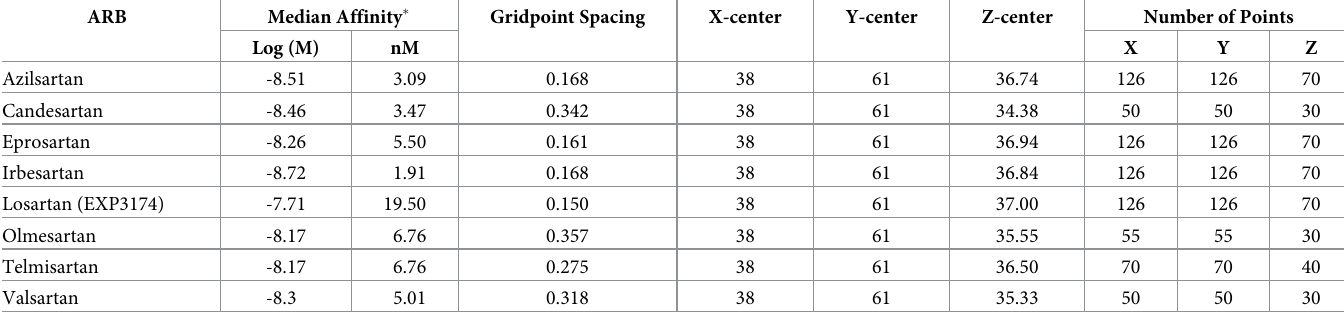
Table 3. Optimal AutoDock 4.2 parameters identified to obtain known median affinity for each ARBs to the apo-AT 1 R model. ARB Median Affinity �